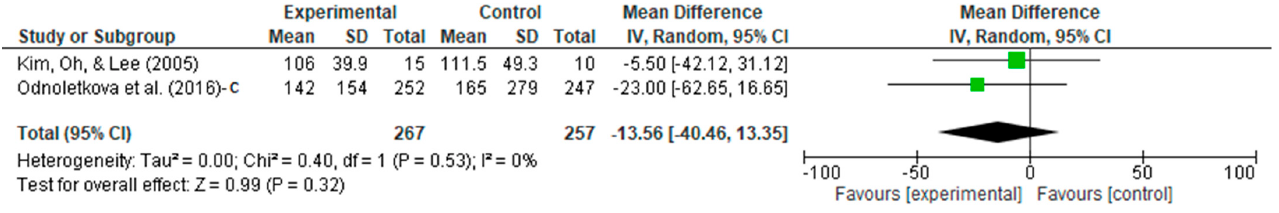
Figure 10. Forest plot intervention vs. control of telecoaching in achieving a triglycerides outcome [16,21].